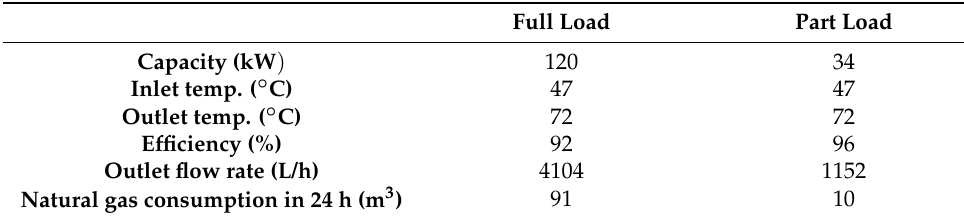
Table 9. The characteristics of the boiler in district heating system.